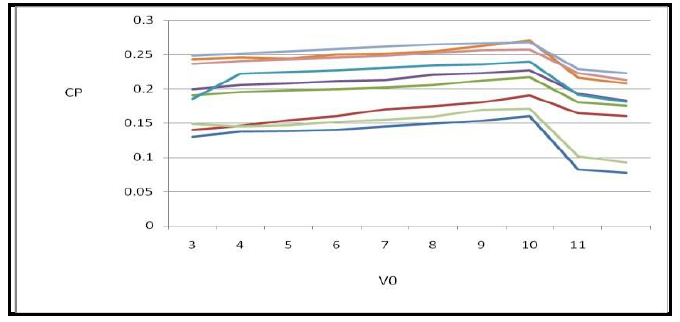
Fig. 1. Graph of CP versus